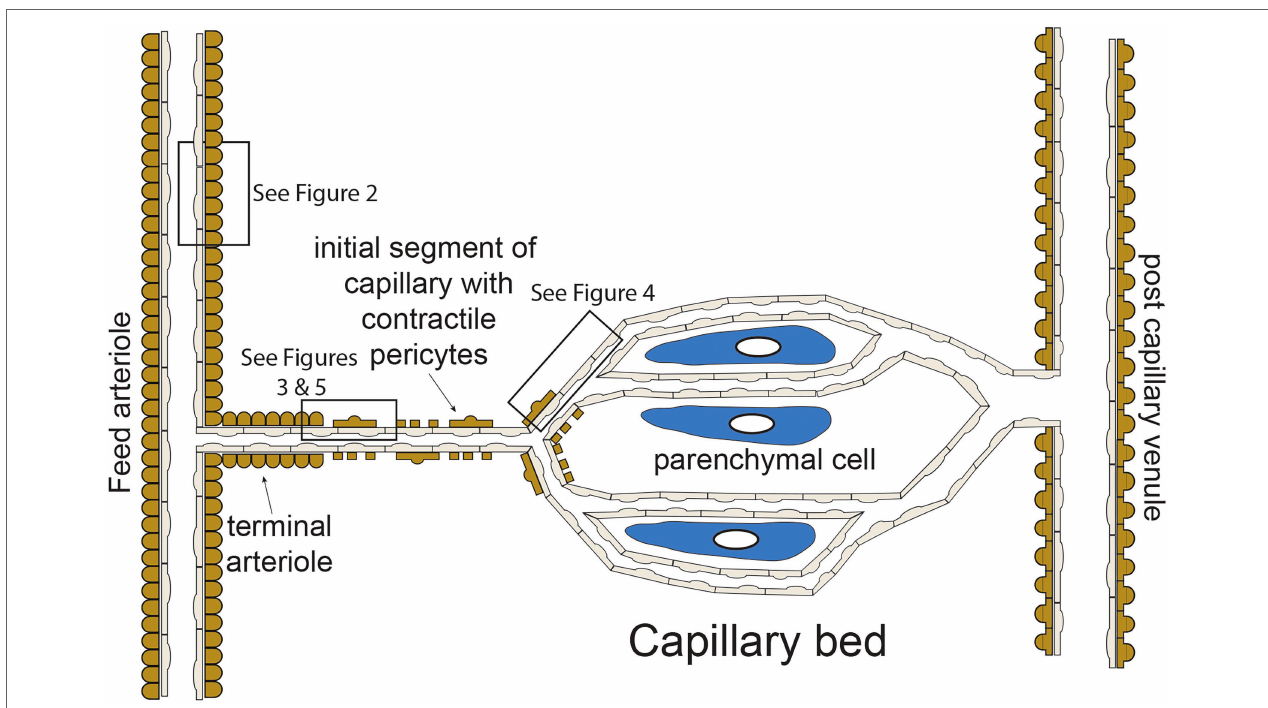
FIGURE 1 | Microvascular unit—schematic representation of hypothetical microvascular unit that consists of a feed arteriole that branches into a terminal arteriole. The terminal arteriole transitions into an initial capillary segment that is coated with contractile pericytes including at the initial branch points, as shown. As the capillaries progress, they lose coverage by contractile pericytes which are replaces by non-contractile pericytes (not shown in the figure for clarity). As shown, the capillaries are in close association with parenchymal cells. The capillaries then converge and eventually drain into venules, which are coated in pericytic smooth muscle cells that are morphologically distinct from arteriolar smooth muscle cells. Boxes in the figure depict regions corresponding to Figures 2 – 5 as shown. See text for details and